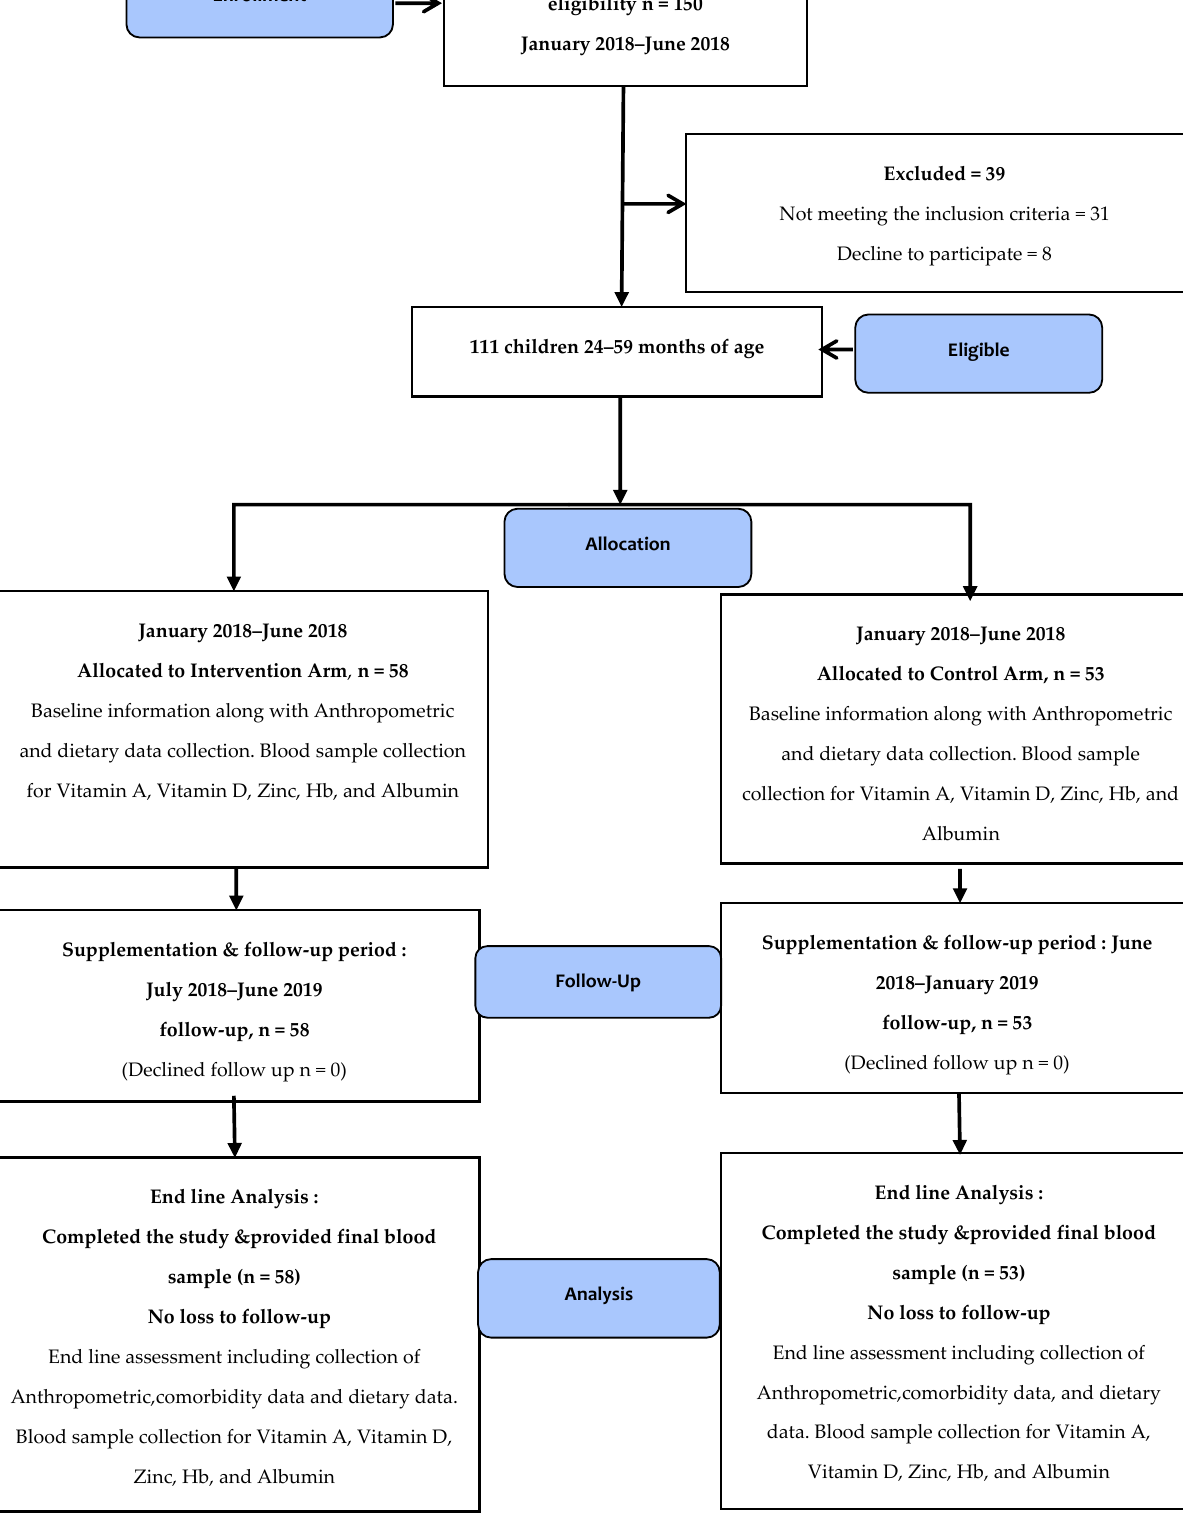
Figure 1. Consort diagram.